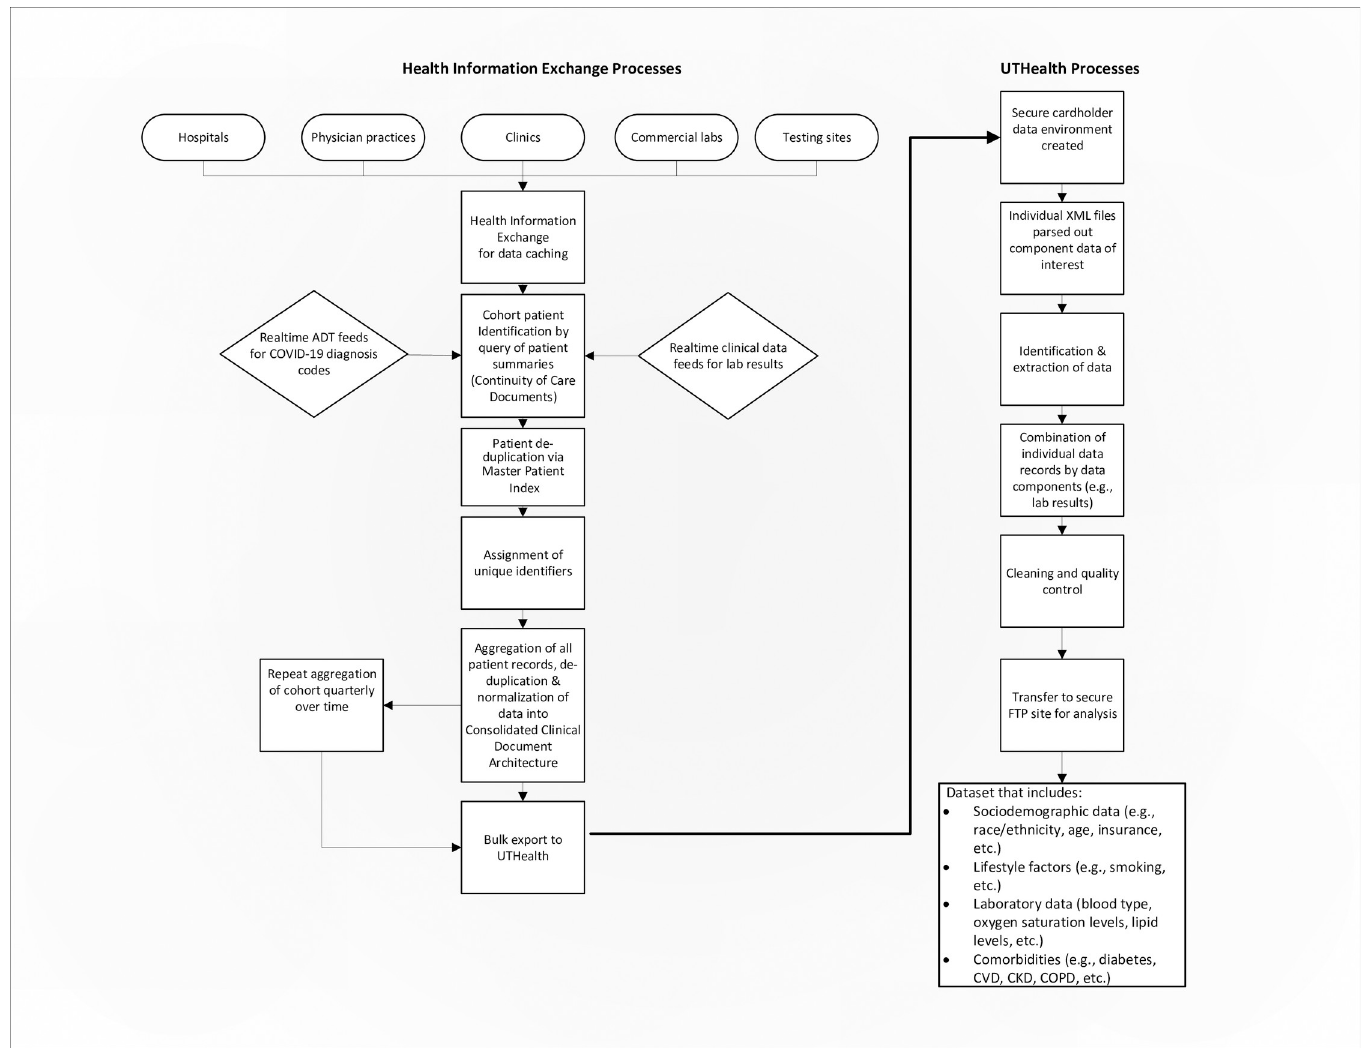
Fig 1. Data extraction and